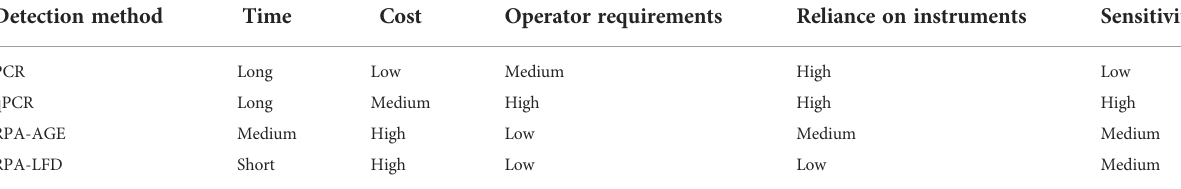
TABLE 1 The advantages and disadvantages of PCR, qPCR, RPA-AGE and RPA-LFD detection method. Detection